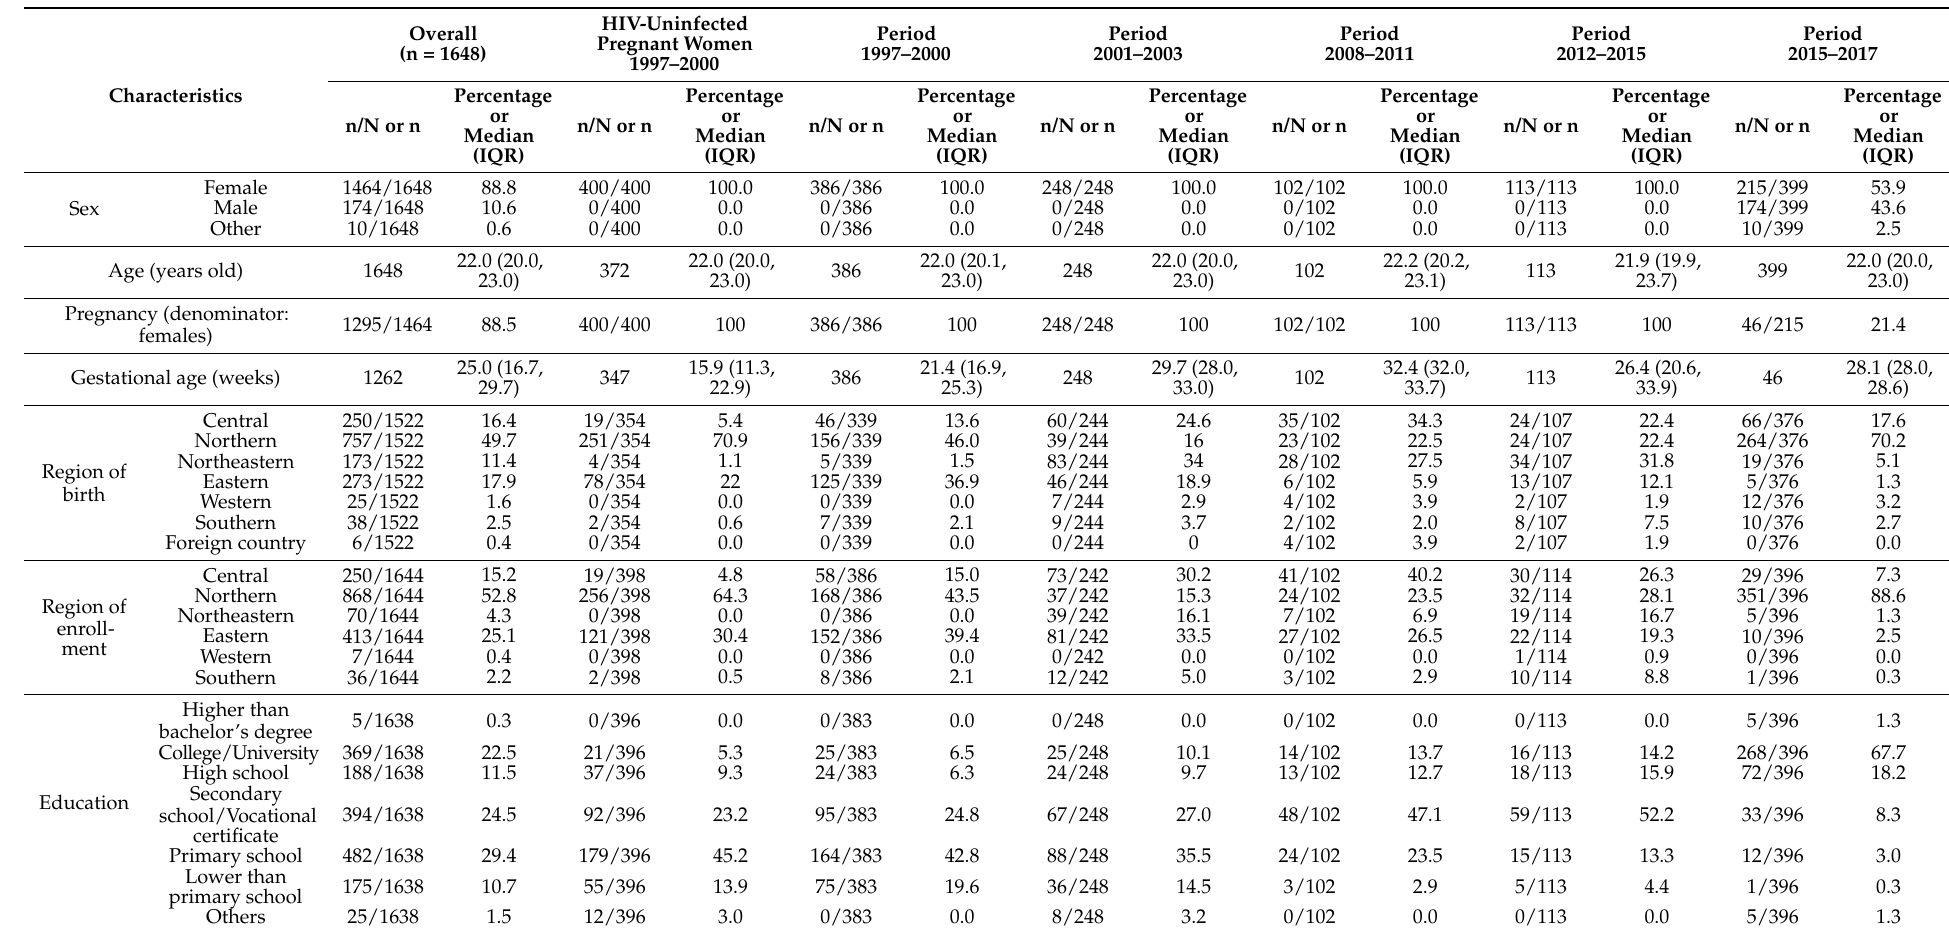
Table 1. Characteristics of the study